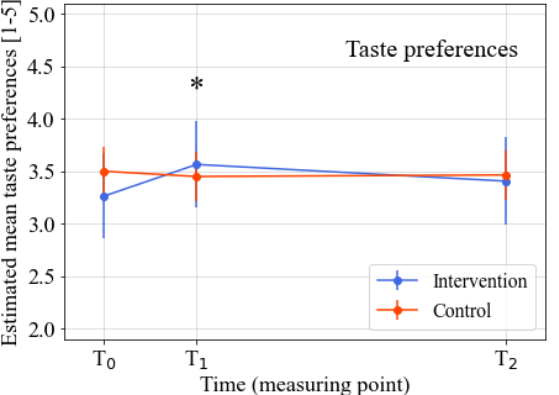
Figure 4. Estimated marginal means of attitude towards addressed FV product from T0–T2. Note. Time span: T1–T0 = three weeks; T2–T0 = three months. * Significant difference between the inter- vention and control group ( p ≤ 0.05). Analyzed by linear mixed model analyses. All analyses were corrected for baseline outcome, sex, age, FV product assessed in the questionnaire, and the baseline scores of the other four determinants of FV intake.